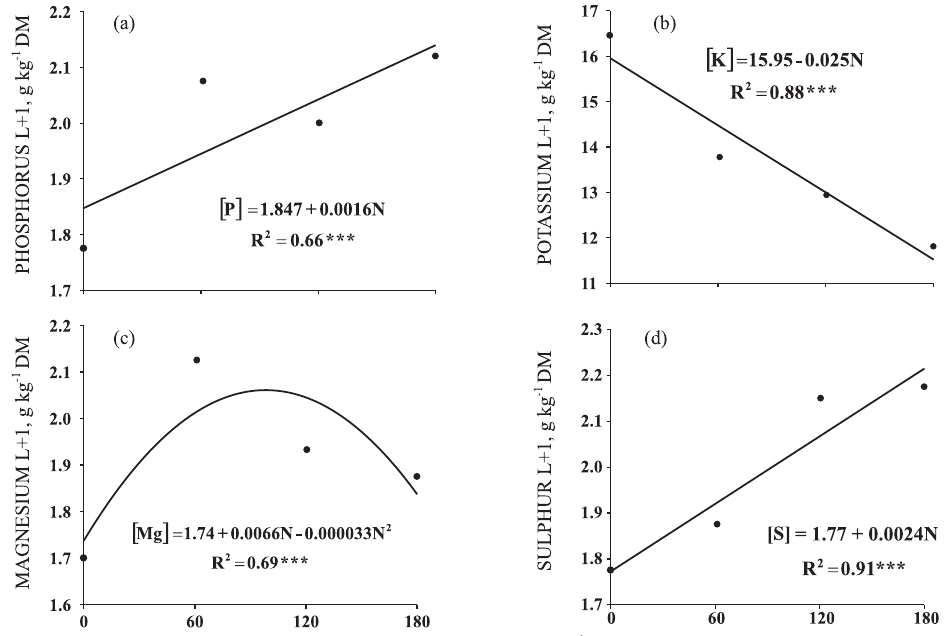
Figure 4. Macronutrient concentrations in leaf diagnosis in the second ratoon of sugarcane 60 d.a.f. in terms of the doses of N-NH Cl (sampling of leaf +1). *** significant at 1 4